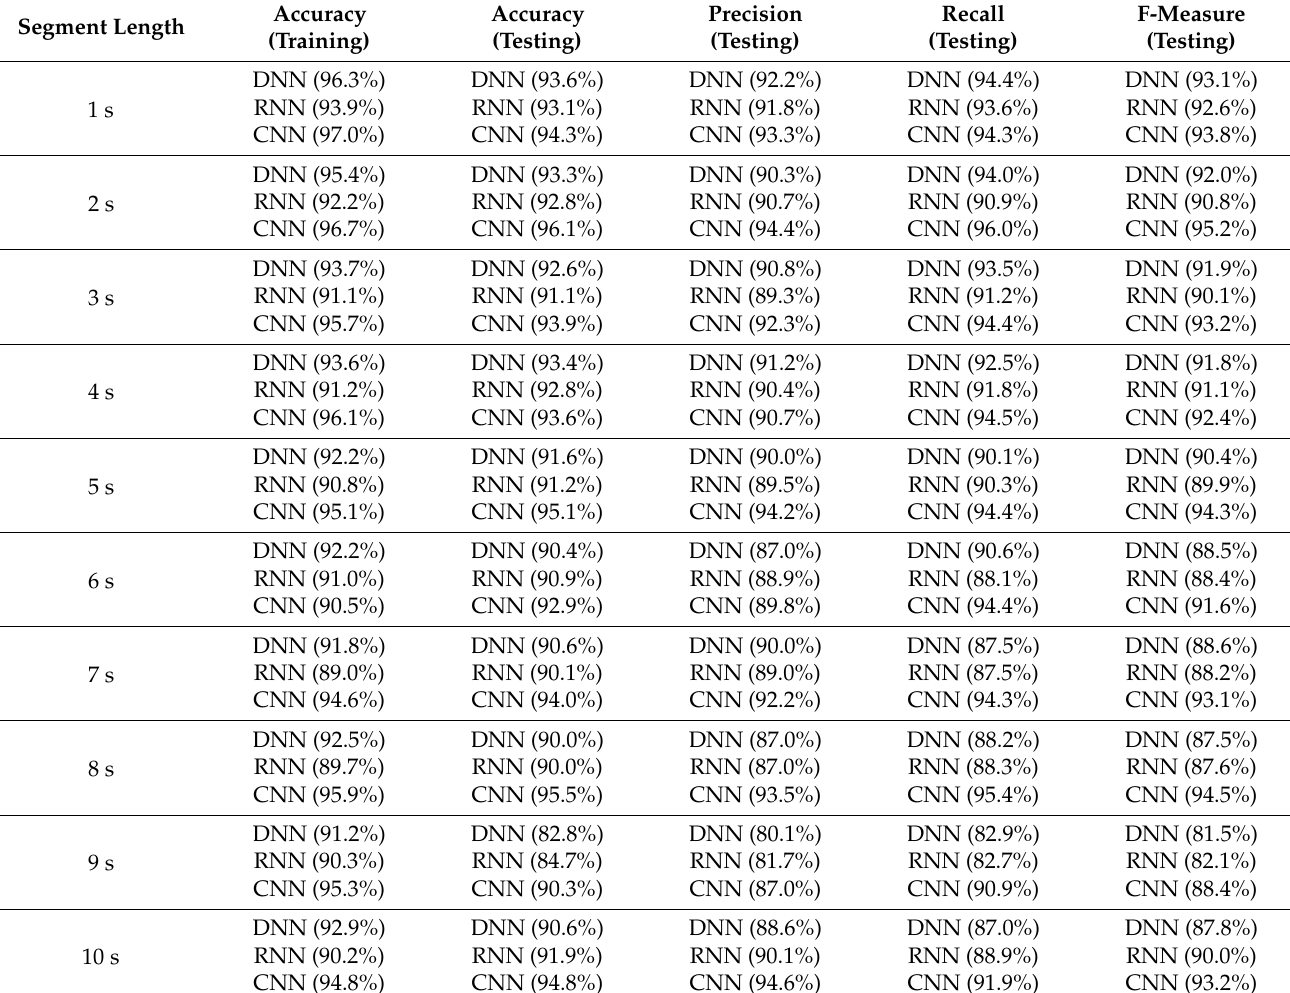
Table 6. Performance of modulated algorithms on segments 1–10 s